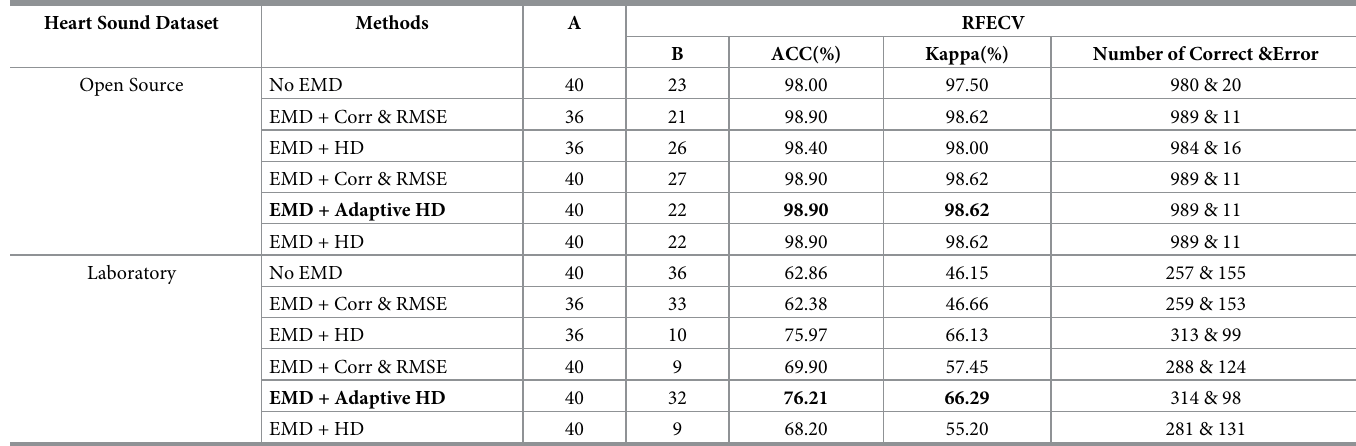
Table 9. Comparison of accuracy and feature dimension under different methods based on RFECV.